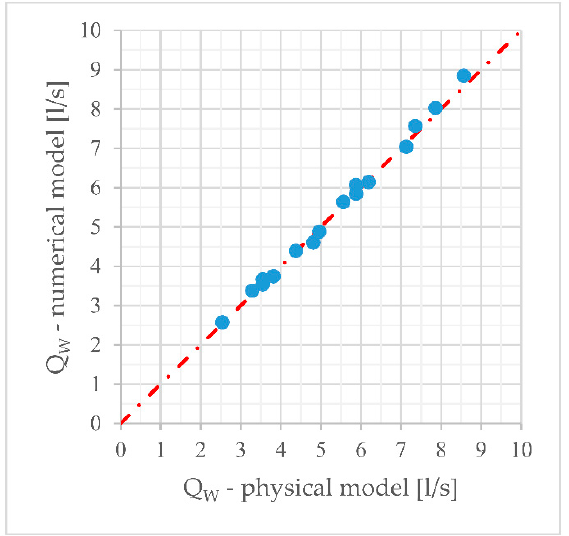
Figure 7. Comparison of weir discharges in the physical and numerical model.